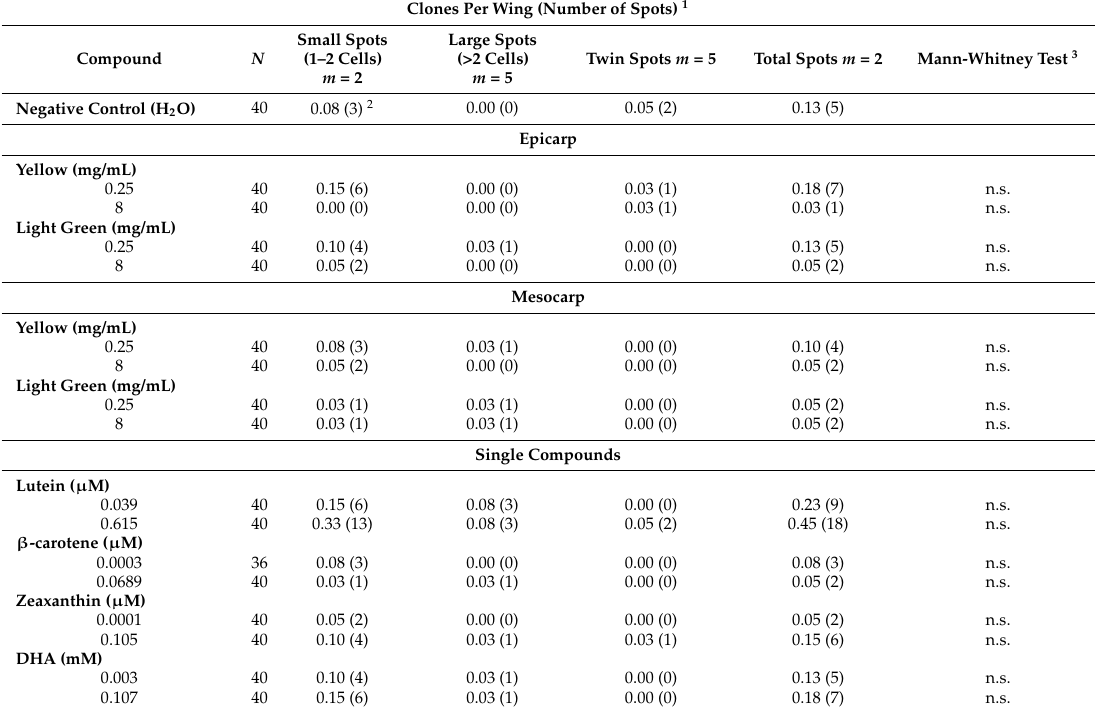
Table 2. Genotoxicity (single treatment) of epicarp and mesocarp of two varieties of C. pepo and its active compounds (lutein, β -carotene, zeaxanthin and dehydroascorbic acid) in the Drosophila Wing Spot